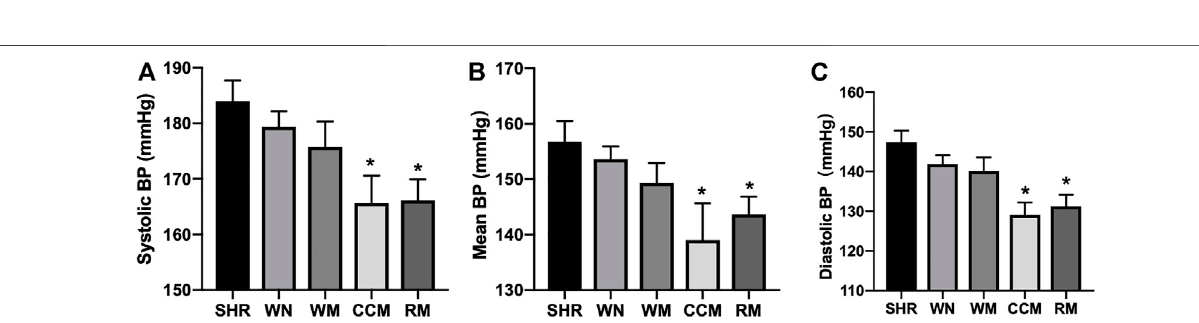
Frontiers in Pharmacology |